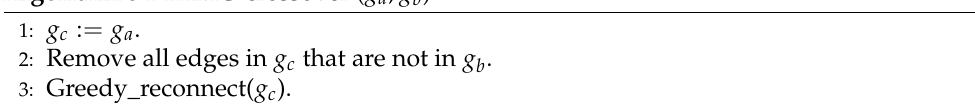
Algorithm 5 PTAMG-crossover ( g a , g b